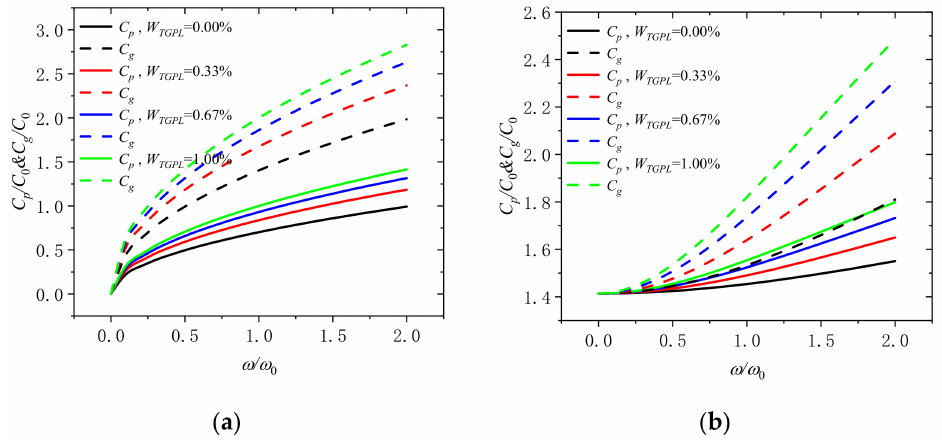
Figure 4. Phase speed and group speed in rotating microbeam with different weight fraction of GPLs ( W TGPL = 0.00%, 0.33%, 0.67%, and 1.00%) for ( a ) Ω / Ω 0 = 0 and ( b ) Ω / Ω 0 = 2.